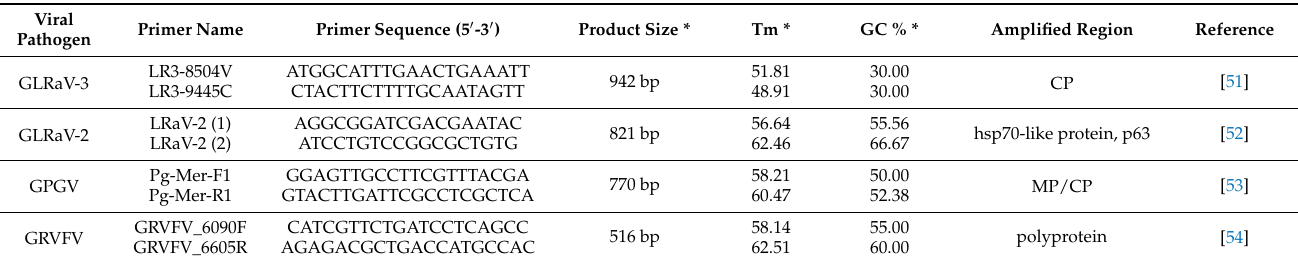
Table 1. List of primers used for mRT-PCR